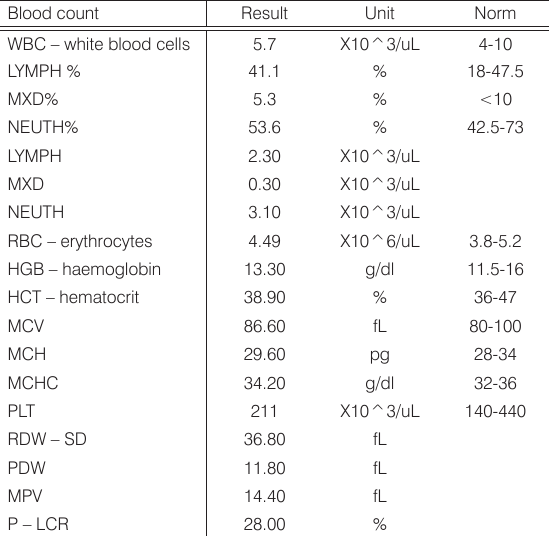
Table 4. Results of the laboratory tests - haematology.